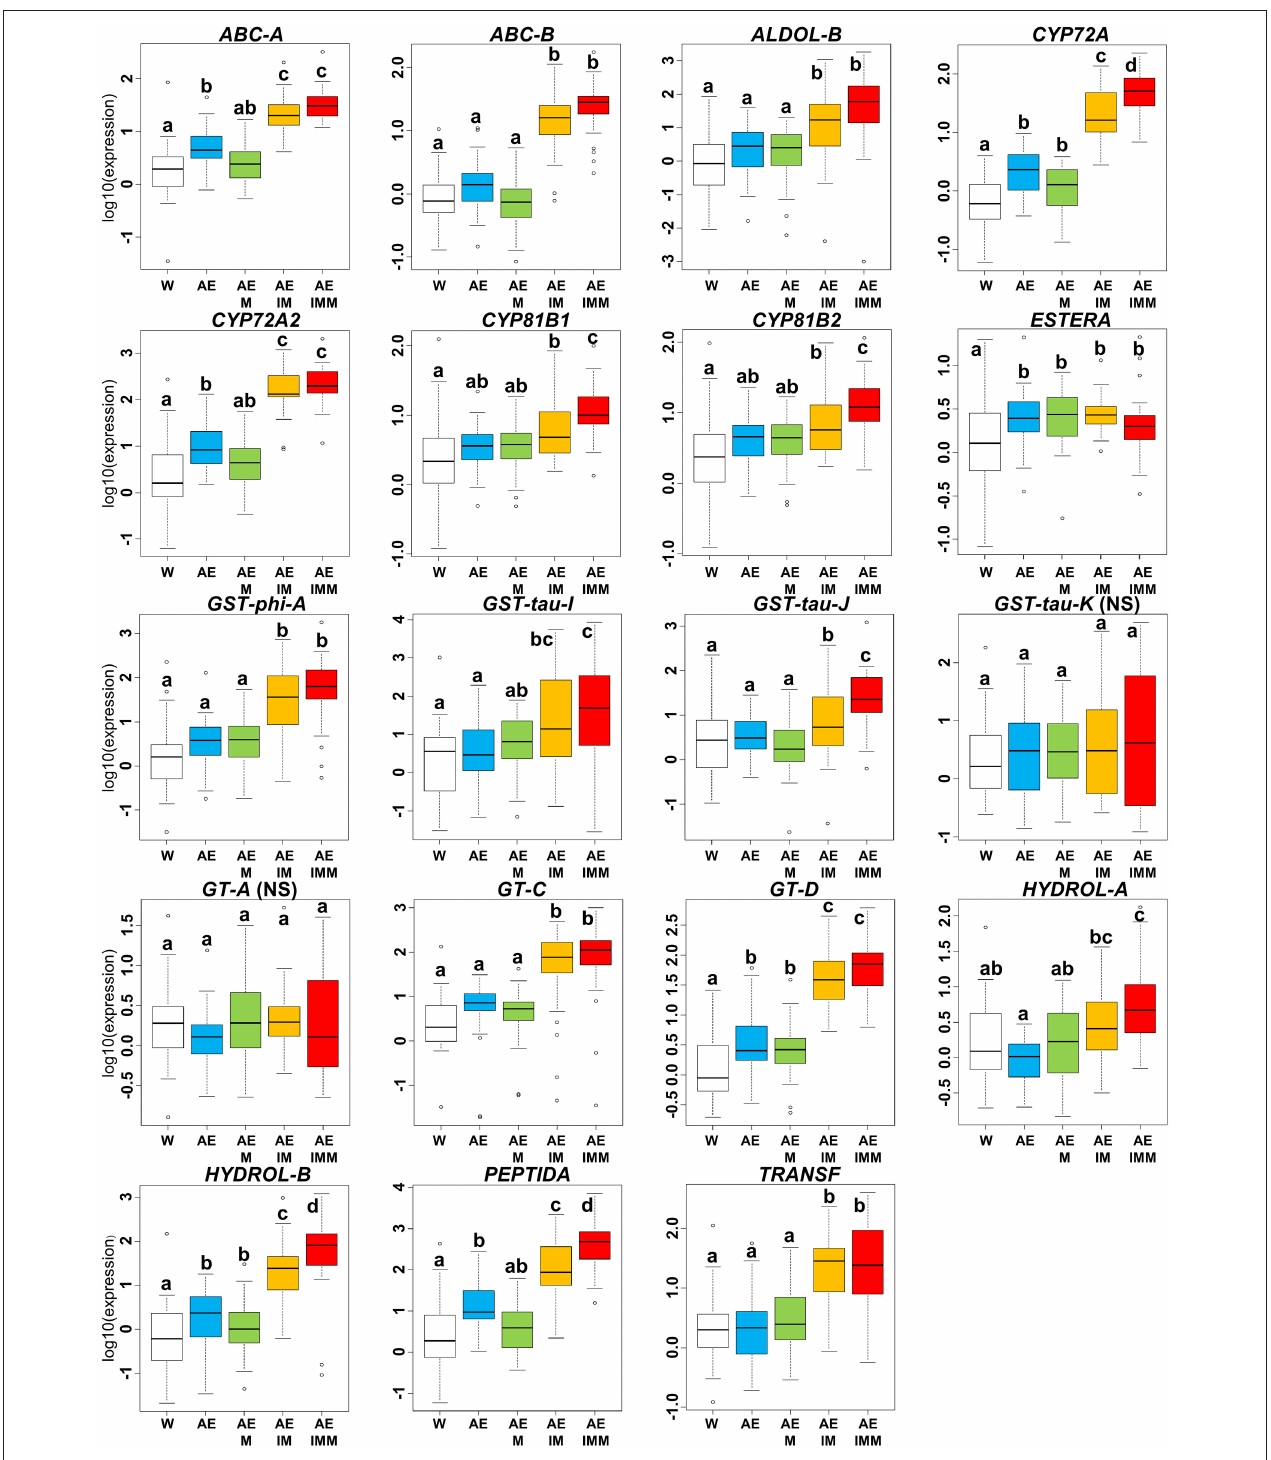
FIGURE 5 | Variation of relative expression levels of 19 NTSR marker genes among experimental modalities in the iodosulfuron + mesosulfuron and mefenpyr-diethyl experiment. Expression levels 24 h after treatment are averaged over the 36 rye-grass plants studied. Experimental modalities: W, water; AE, Actirob (adjuvant recommended for herbicide application) + ethoxylated castor oil; AEM, Actirob + ethoxylated castor oil + mefenpyr-diethyl; AEIM; Actirob + ethoxylated castor oil + iodosulfuron + mesosulfuron; AEIMM, Actirob + ethoxylated castor oil + iodosulfuron + mesosulfuron + mefenpyr-diethyl. For each marker, different letters indicate significantly different expression levels (Tukey’s test, p < 0.05). NS, marker for which no significant effect of the experimental modality was detected in ANOVA ( Table 3 ).